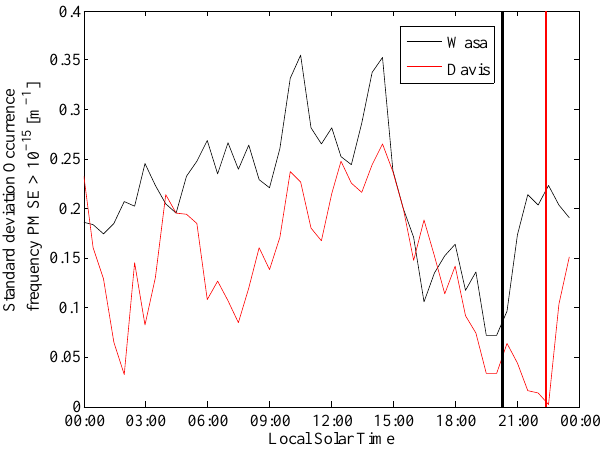
Fig. 6. Scatter plot of temperature minus frost point from Aura MLS data, average of data points centered on 83 and 86 km altitude (x-axis [K]) and PMSE occurrence frequency (y-axis). Wasa data is shown with black circles, Davis with red triangles. Least square fits of a linear function are shown with solid lines. A thick black line indicates a fit to all the